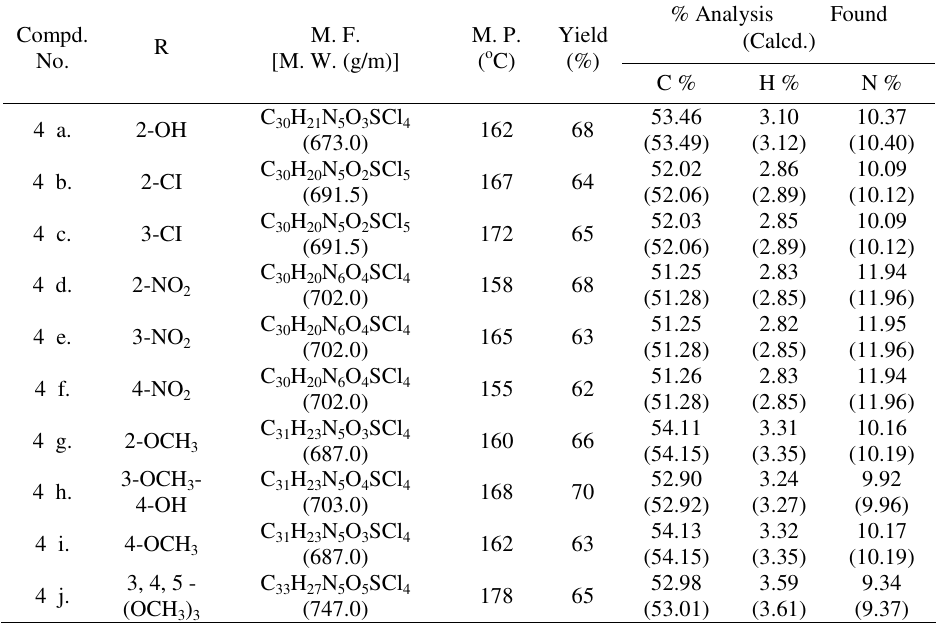
Table 4. PHYSICAL AND ANALYTICAL DATA OF COMPOUNDS [4(a-j )]